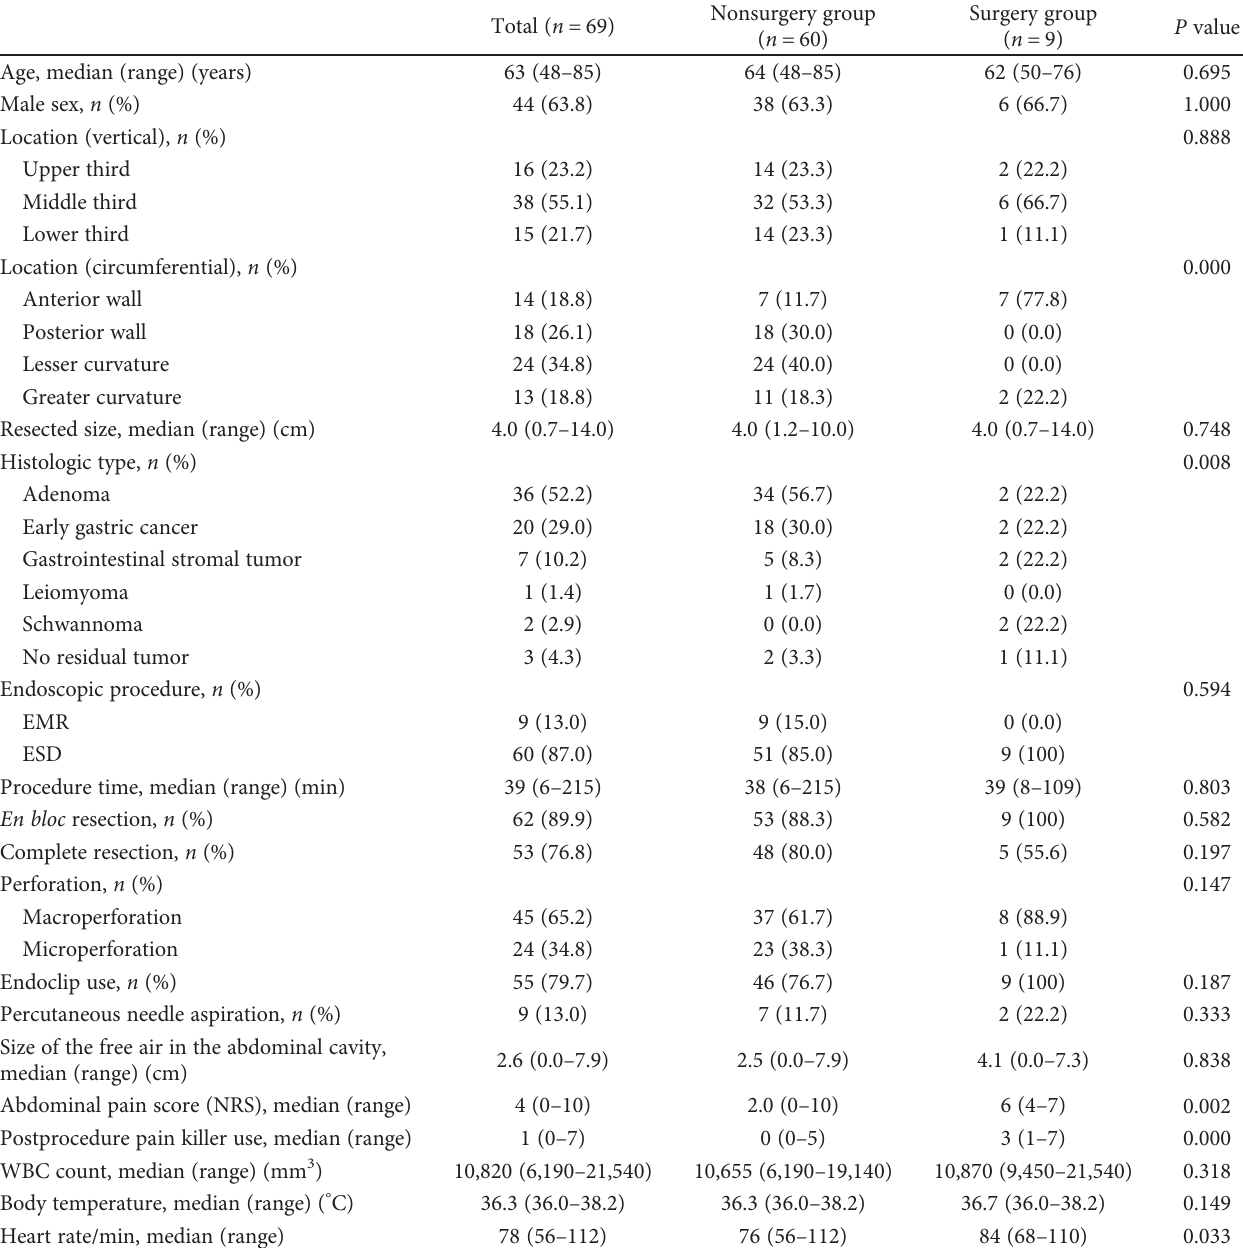
Table 1: Basic characteristics of the 69 patients with